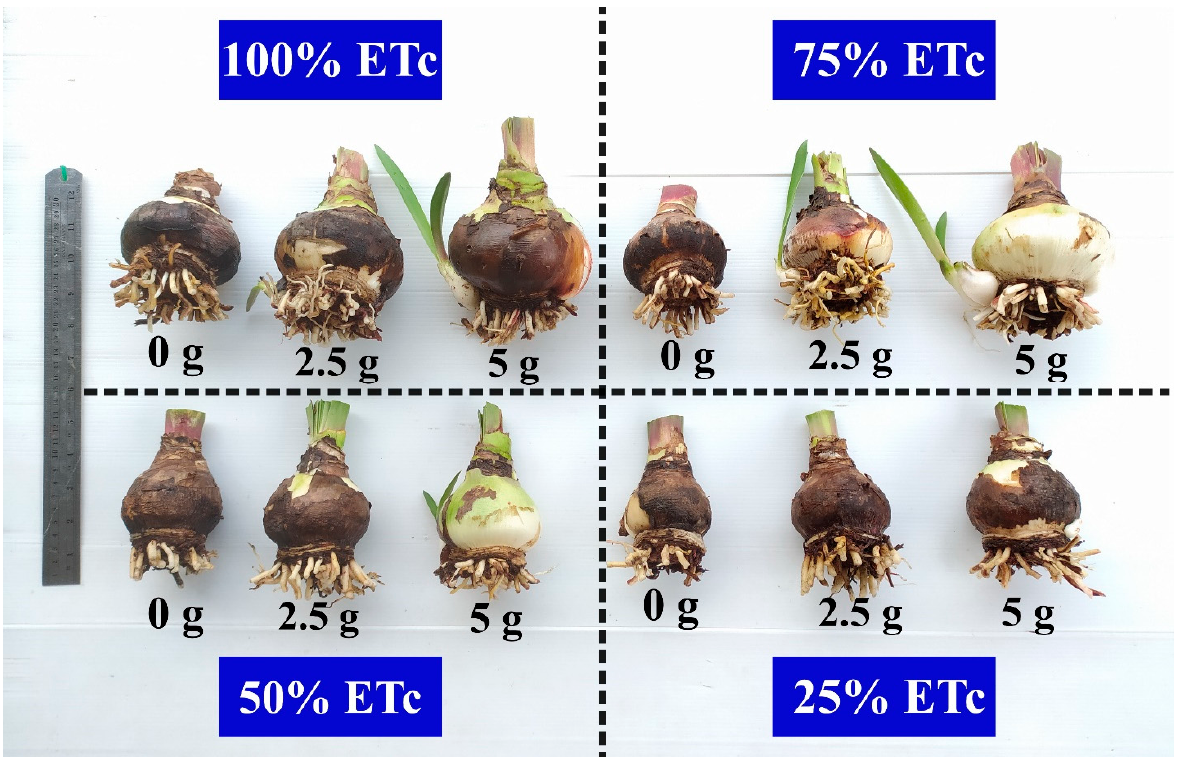
Figure 5. Bulb quality of Hippeastrum ‘Red Lion’ grown under different irrigation level combinations with different fertilization rates 180 days after planting.